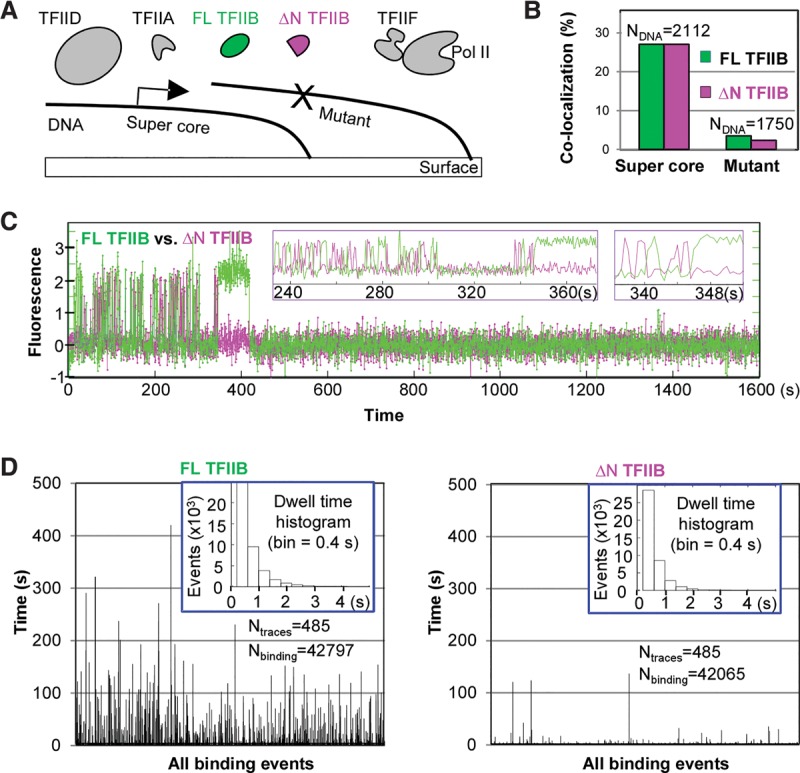
The N-terminal domain of TFIIB is required for the transient-to-stable binding transition. (A) Scheme: Differentially labeled FL and N-terminal (1–106)-deleted (ΔN) TFIIB (4 nM each; false-colored in green and magenta, respectively) were incubated with unlabeled (black) TFIID, TFIIA, TFIIF, and Pol II for binding to immobilized DNA templates. (B) Colocalization of FL and ΔN TFIIB to the supercore or mutant promoter-containing DNA templates during a 27-min (1600-sec) incubation. (C) A representative fluorescence time trace showing the binding of FL and ΔN TFIIB proteins to a DNA template containing the supercore promoter. Insets show zoomed-in views. Transient to stable TFIIB binding was observed with ∼50% of the DNA bound by TFIIB, and, among all of these transitions, most of the stable bindings (238 out of 240) were from the FL TFIIB. (D) All TFIIB-binding events are represented by bars (height depicts residence time) to highlight the long events, which are vastly outnumbered by the short ones in the histograms (insets).